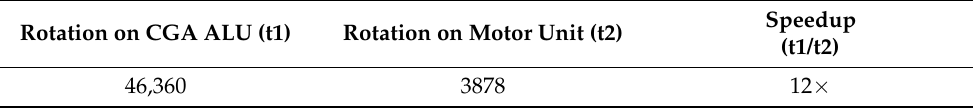
Table 8. Comparison of average execution times (measured in clock cycles at 125 MHz) of a rotation operation on the CGA ALU and on the motor unit, along with related speedup.